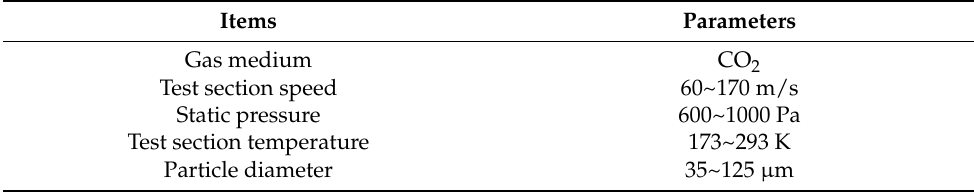
Table 1. The main simulated environmental parameters of the Mars wind tunnel.